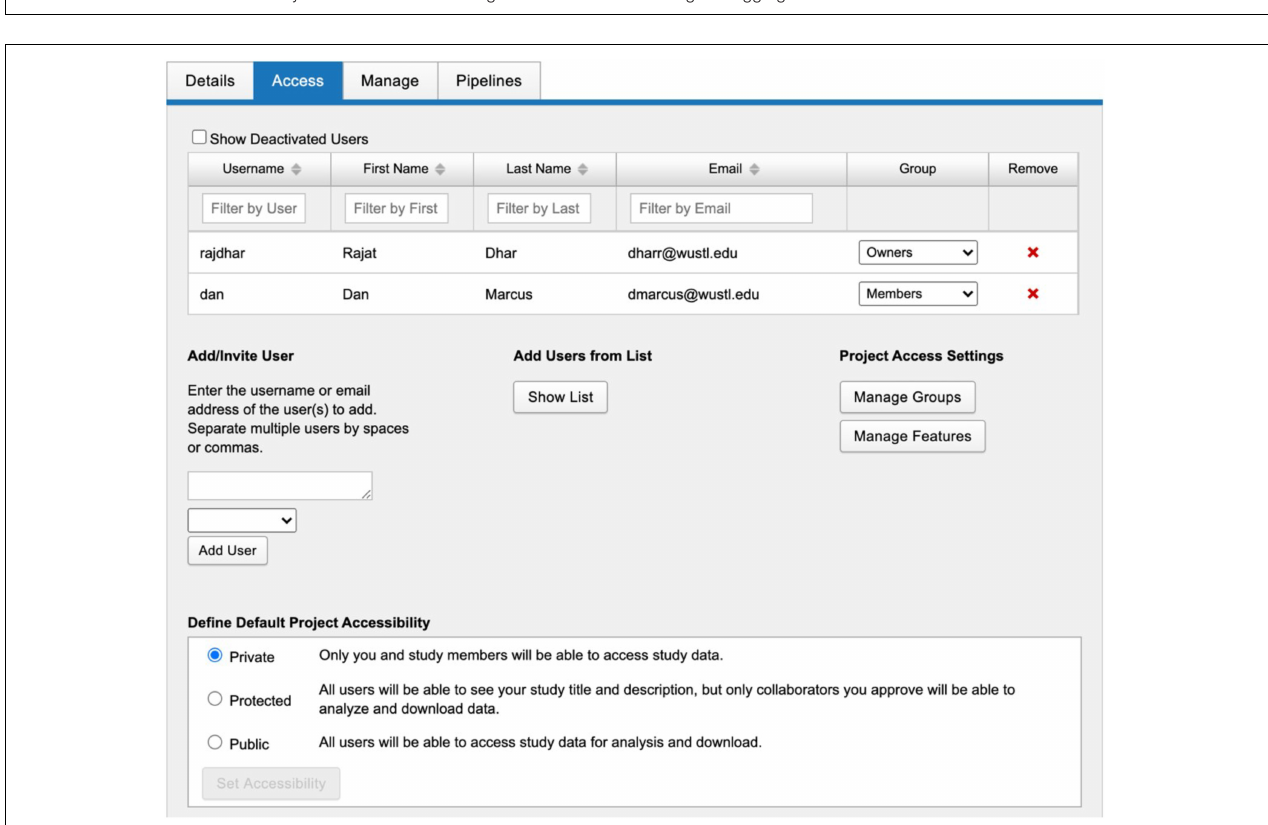
FIGURE 2 | SNIPR uses XNAT’s standard project management mechanism which gives project owners flexible control over access to their data. Projects can be set to public, protected, or private. Protected project data are only accessible to users who have been explicitly granted access to the project.